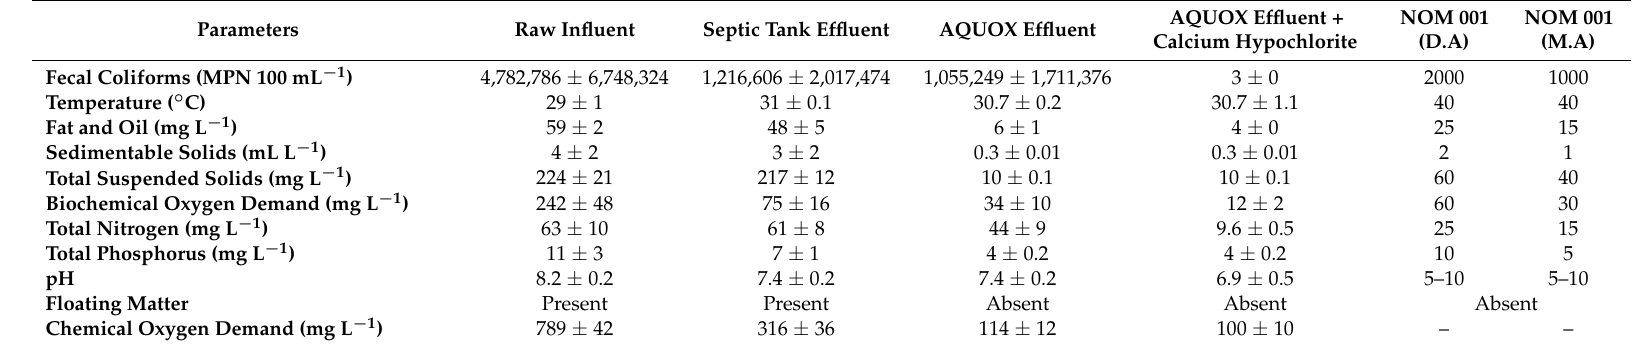
Table 1. Results of the wastewater quality after each step in the treatment process. D.A.—daily average; M.A.—monthly average.